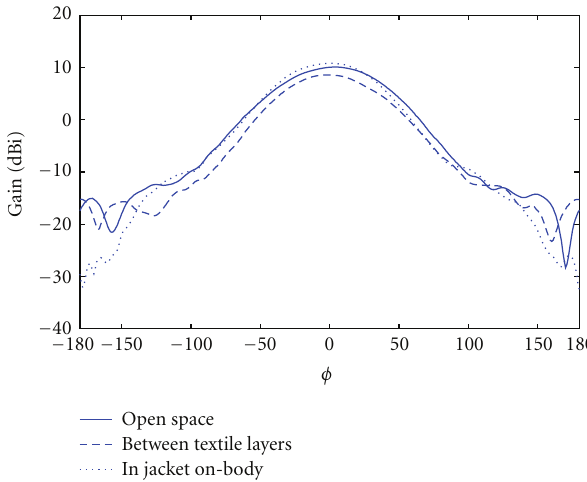
Figure 19: Measured gain pattern in the azimuth plane ( yz -plane) at 2.45 GHz in three di ff erent situations: array in open space (full line), array placed between textile layers (dashed line), and array placed on-body in a firefighter jacket (dotted